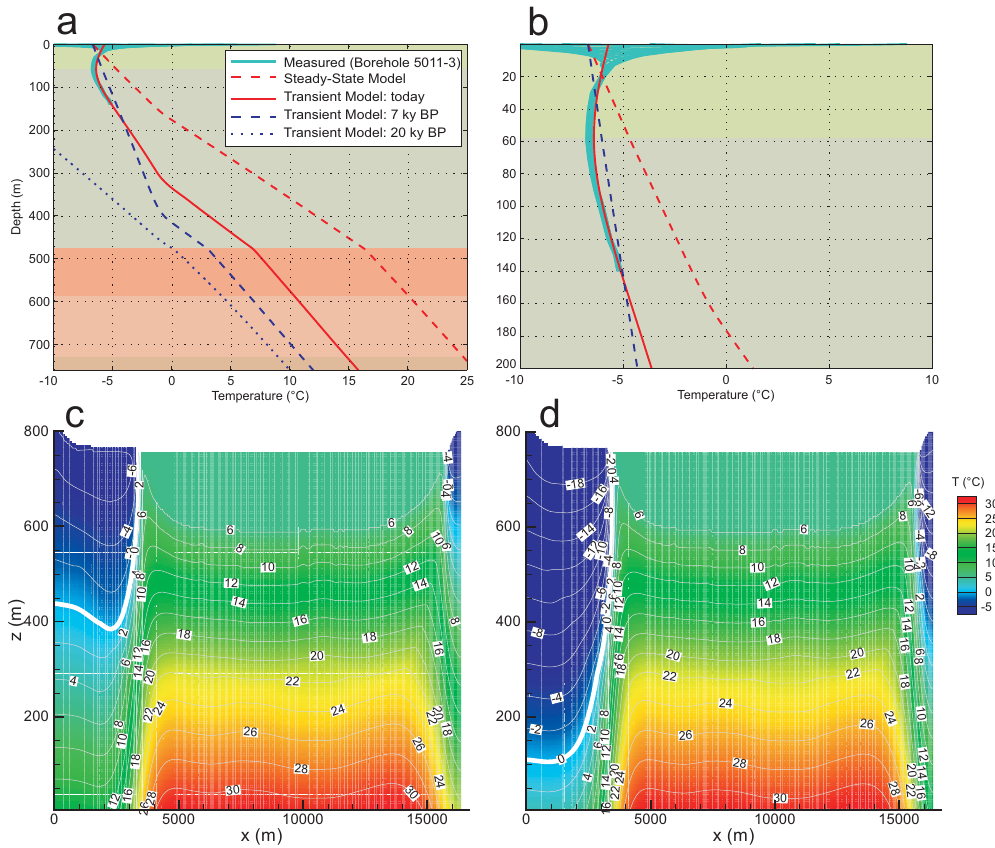
Fig. 8. Results from the transient simulations. Temperature profiles at borehole 5011-3 showing (a) the whole model depth, and (b) only the upper part. The temperature field of the model (c) today, and 20kyr BP (d) . The vertical scale is greatly exaggerated. Table 4. The five lithological units and their thermal parameters. Thermal conductivity λ is varied within the given ranges, which is ± 20% of the mean value. φ is porosity, λ bulk denotes the total (bulk) thermal conductivity for the unfrozen material, and ρ c P is volumetric heat capacity. The values in bold correspond to the measured properties of the sample from unit 1, 3, and